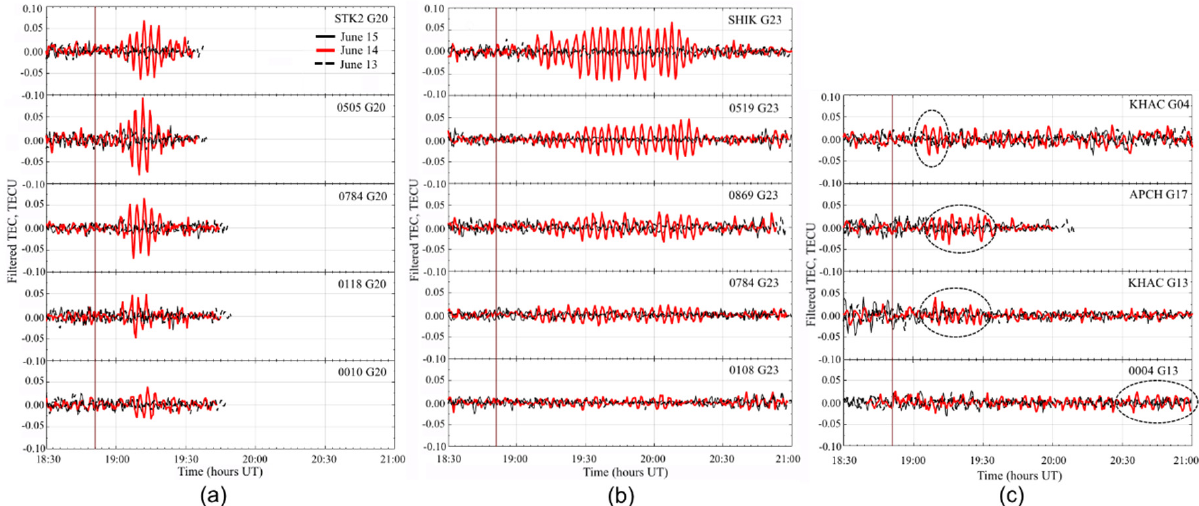
Figure 3. Examples of covolcanic ionospheric disturbances (CVIDs) triggered by the volcanic explosion occurred at 18:51 UT on 14 June 2009. TEC series for the three consecutive days (13–15 June) are plotted. ( a , b ) The satellites G20 and G23 filtered vertical TEC series accordingly. ( c ) Covolcanic filtered TEC variations detected to the north and northeast from the volcano (boxes 1–3 from the top to bottom). The last box shows the example of CVIDs observed after 20:30 UT at ~600 km to the southwest from Sarychev Peak. Dashed ellipses constraint illegibly discriminated disturbances for clarity. Site names and the GPS satellite numbers are displayed in the upper right corner of each plot. The vertical red solid line indicates the explosion time according to [17] (Table 1, p. 39).